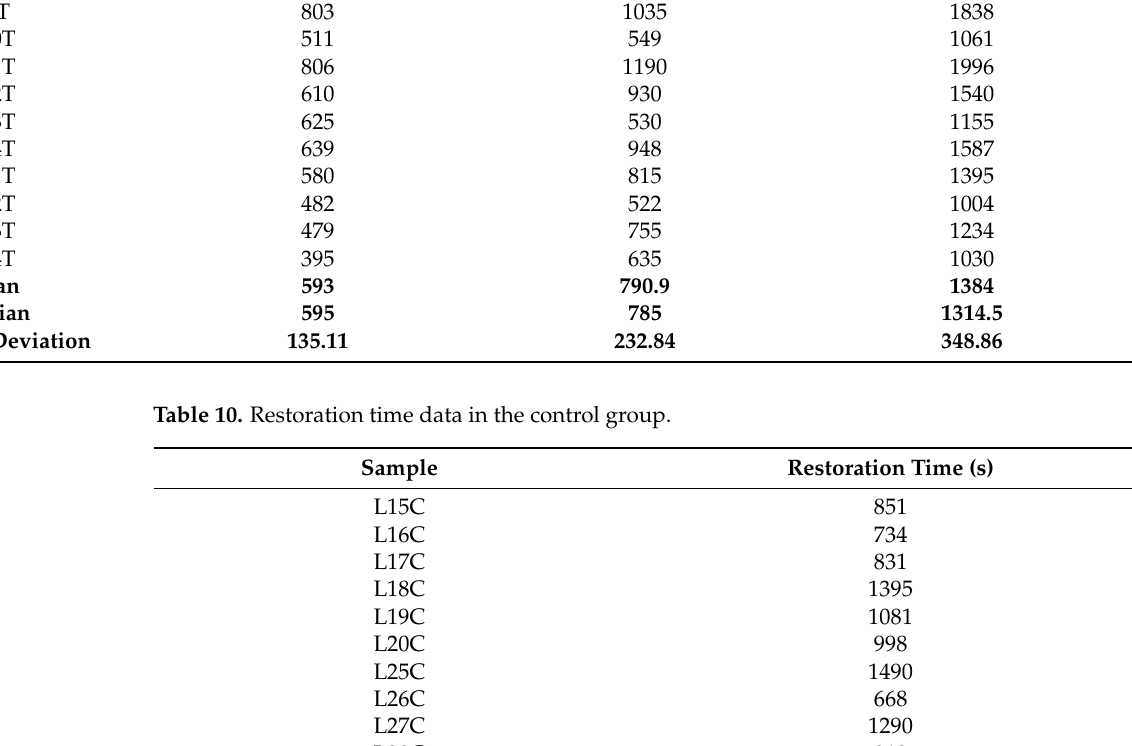
Table 9. Restoration time data in the study group.